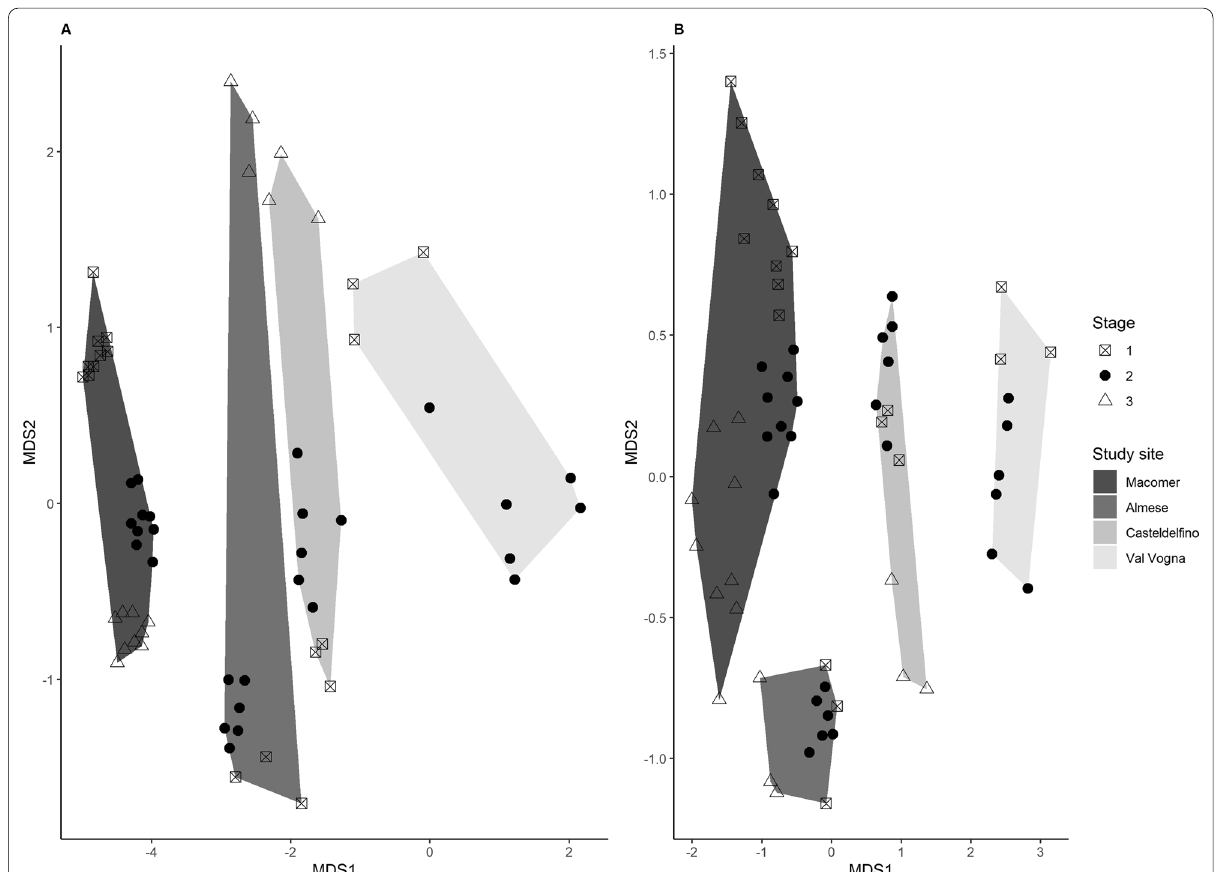
Fig. 3 Non-metric Multidimensional Scaling (NMDS) of plant species percentage cover ( A ) and ant presence-absence ( B ). Sample plot symbols are classified according to the chronosequence stages (1, 2 and 3), whereas convex hulls are coloured based on the study area